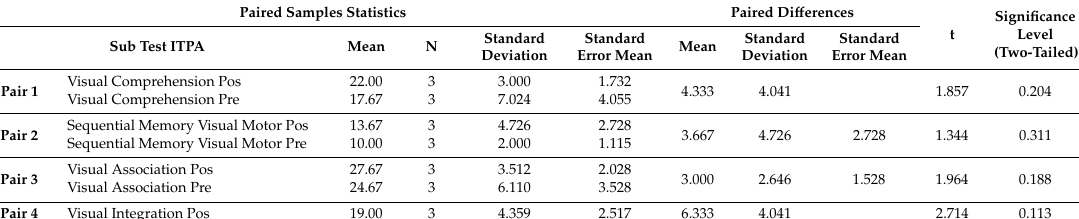
Table 5. Central tendency statistics and relational T-Student in EG for ITPA.